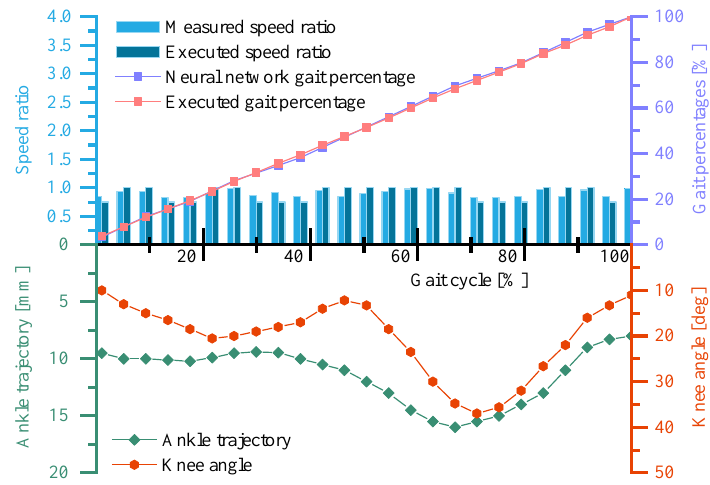
Figure 19. Running states of the neural network control system and the ankle trajectory/knee angle curve of the GFB prosthetic knee during the self-selected speed experiment.